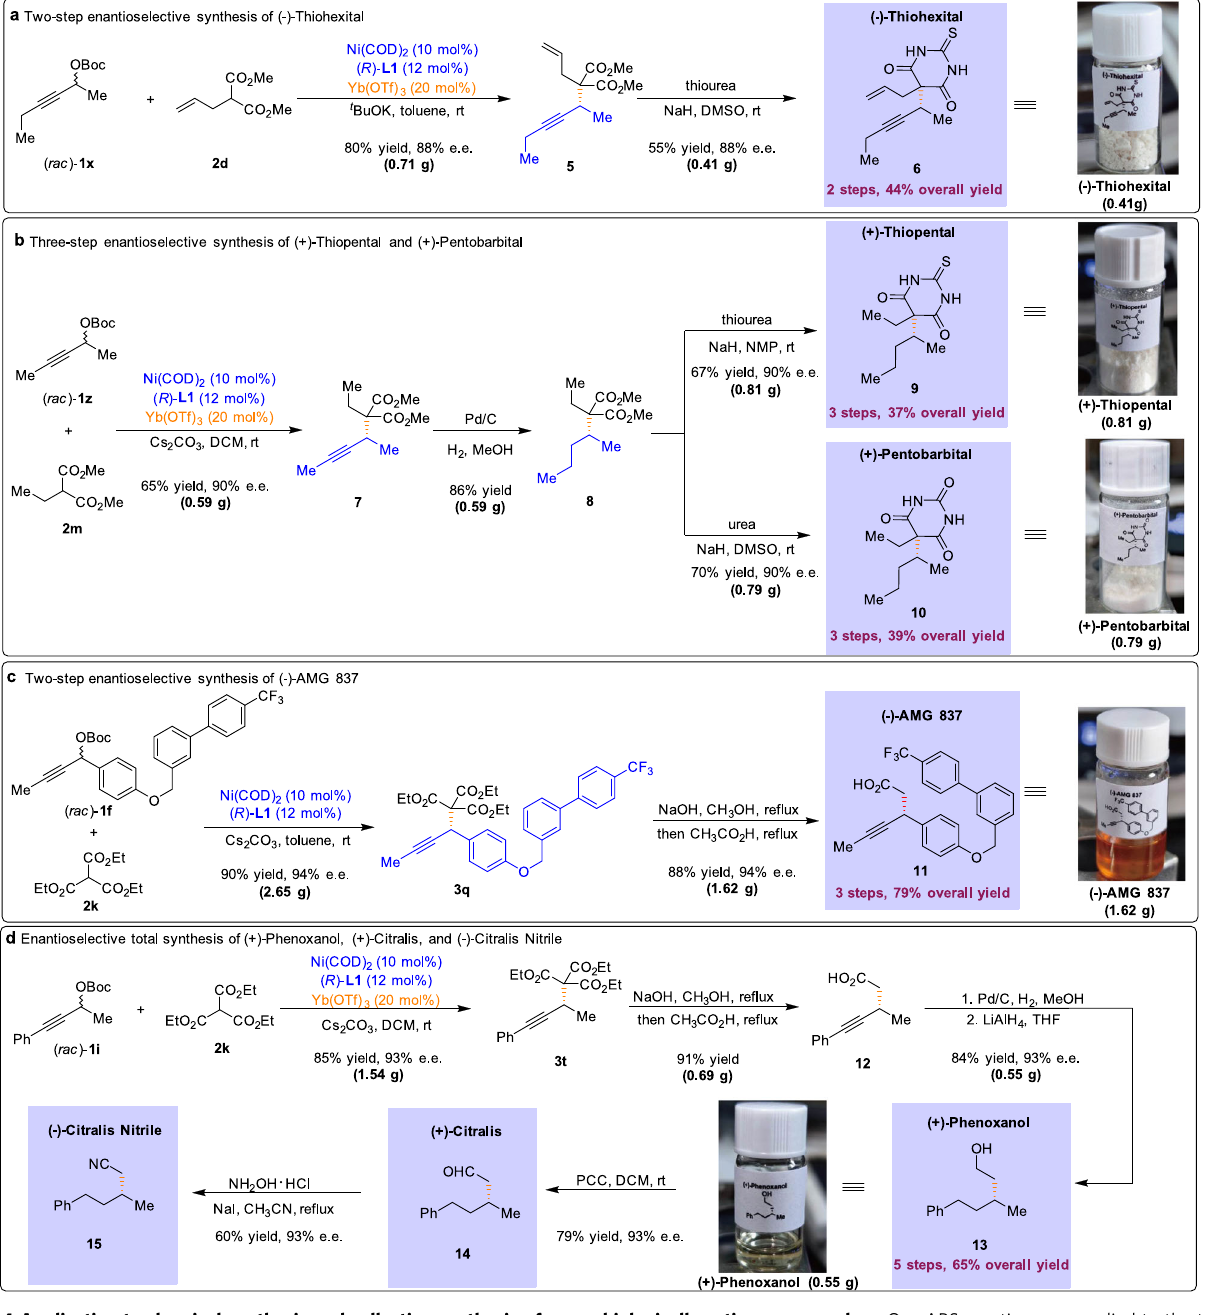
Fig. 4 Application to chemical synthesis and collective synthesis of seven biologically active compounds. a Our APS reaction was applied to the two- step enantioselective synthesis of ( − )-Thiohexital. b The current methodology could allow for the rapid and enantioselective production of ( + )-Thiopental and ( + )-Pentobarbital. c The feasibility of the APS reaction was evaluated in the total synthesis of ( − )-AMG 837. d The APS reaction provided facile access to ( + )-Phenoxanol, ( + )-Citralis, and ( − )-Citralis